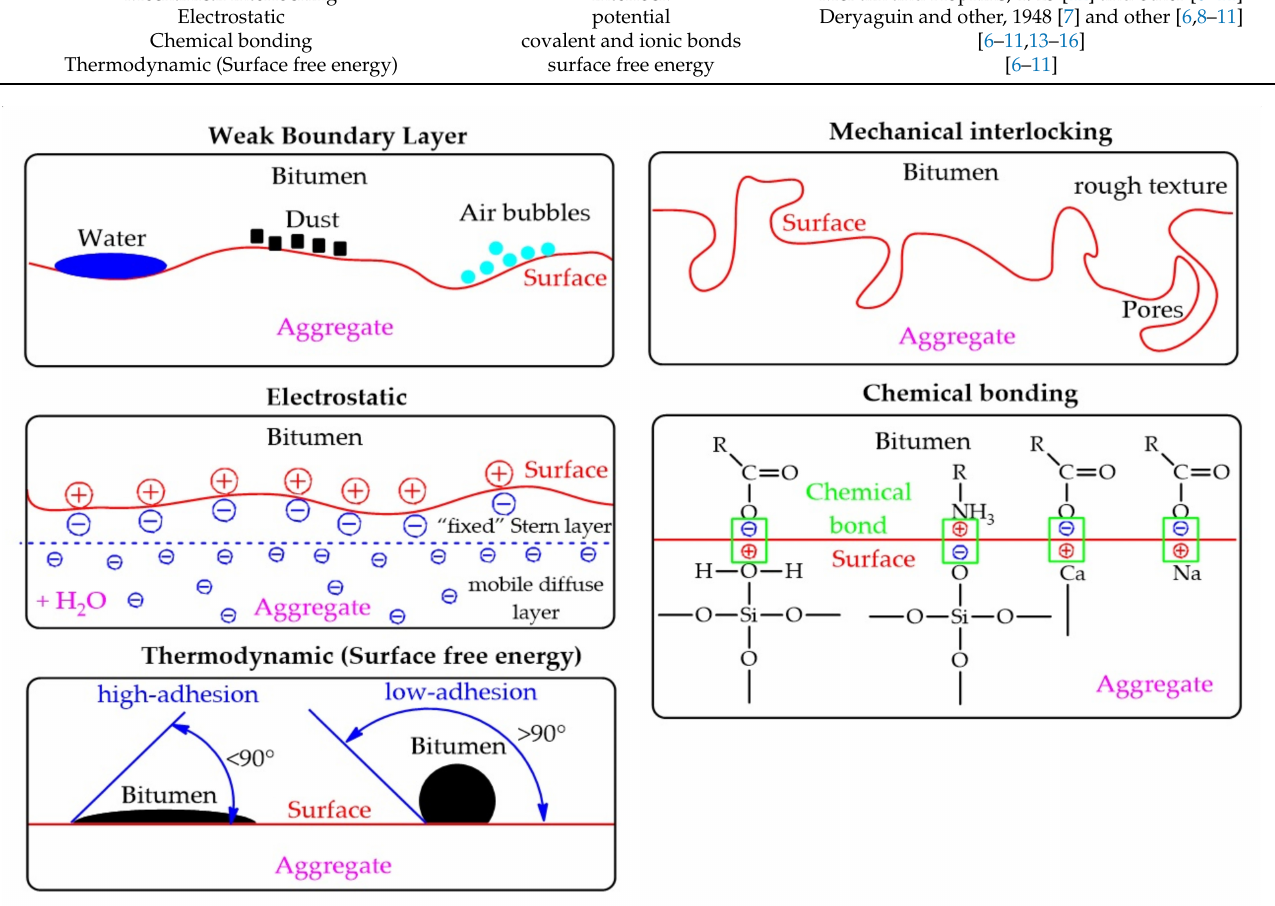
Figure 2. Representation of theories explaining the adhesion mechanism in the bitumen/aggregate